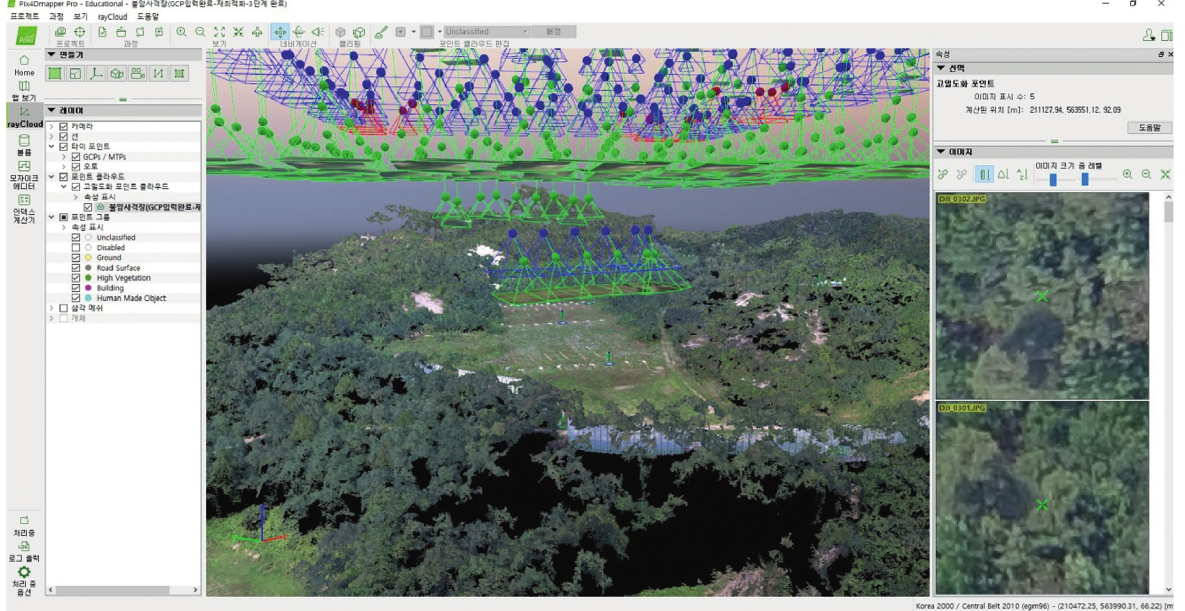
Figure 6: Ground control points settings and generation of dense point clouds.